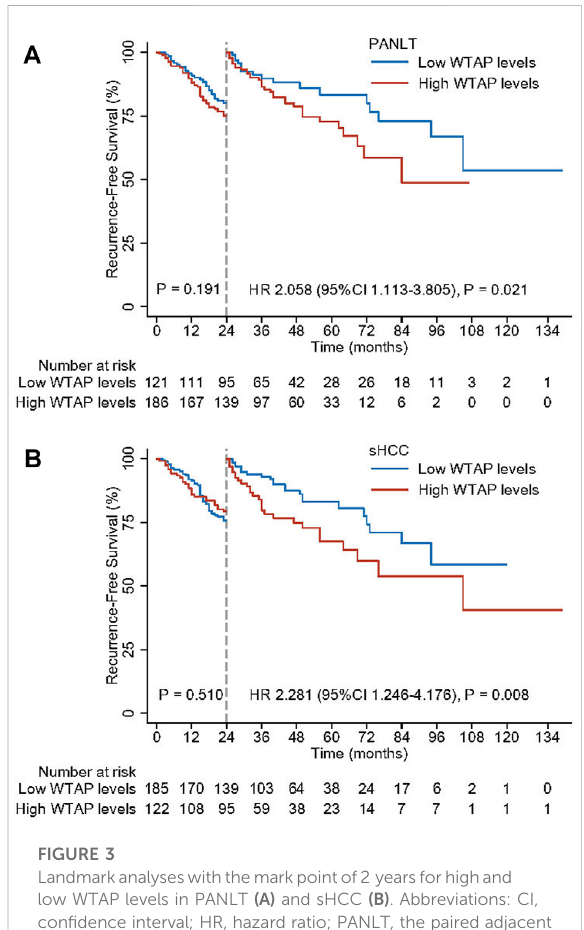
FIGURE 3 Landmarkanalyseswiththemarkpointof2 yearsforhighand low WTAP levels in PANLT (A) and sHCC (B) . Abbreviations: CI, con fi dence interval; HR, hazard ratio; PANLT, the paired adjacent non-neoplastic liver tissues; sHCC, small hepatocellular